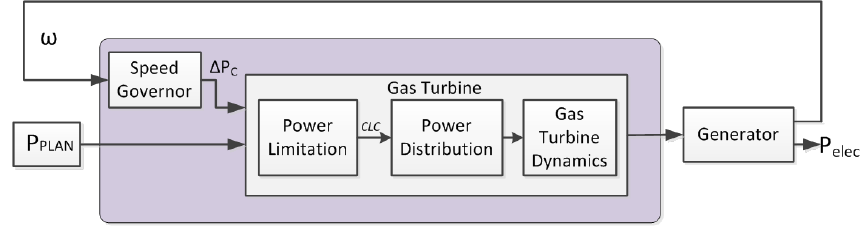
Figure 3. Aggregated DCHP